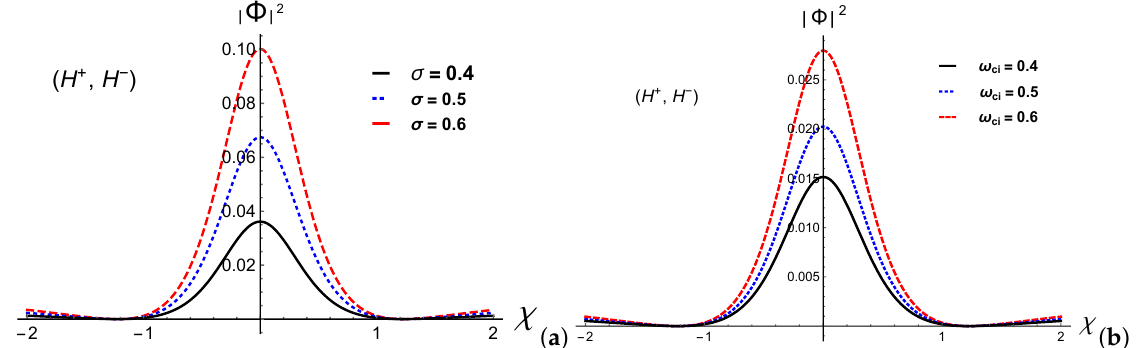
Figure 3. The change of first-order IARWs amplitude versus χ for various values of σ with ω ci = 0.3. ( a ) and ω ci with σ = 0.3 ( b ). Here, r = 0.7, q = 2, β 1 = 0.6, and β 2 =